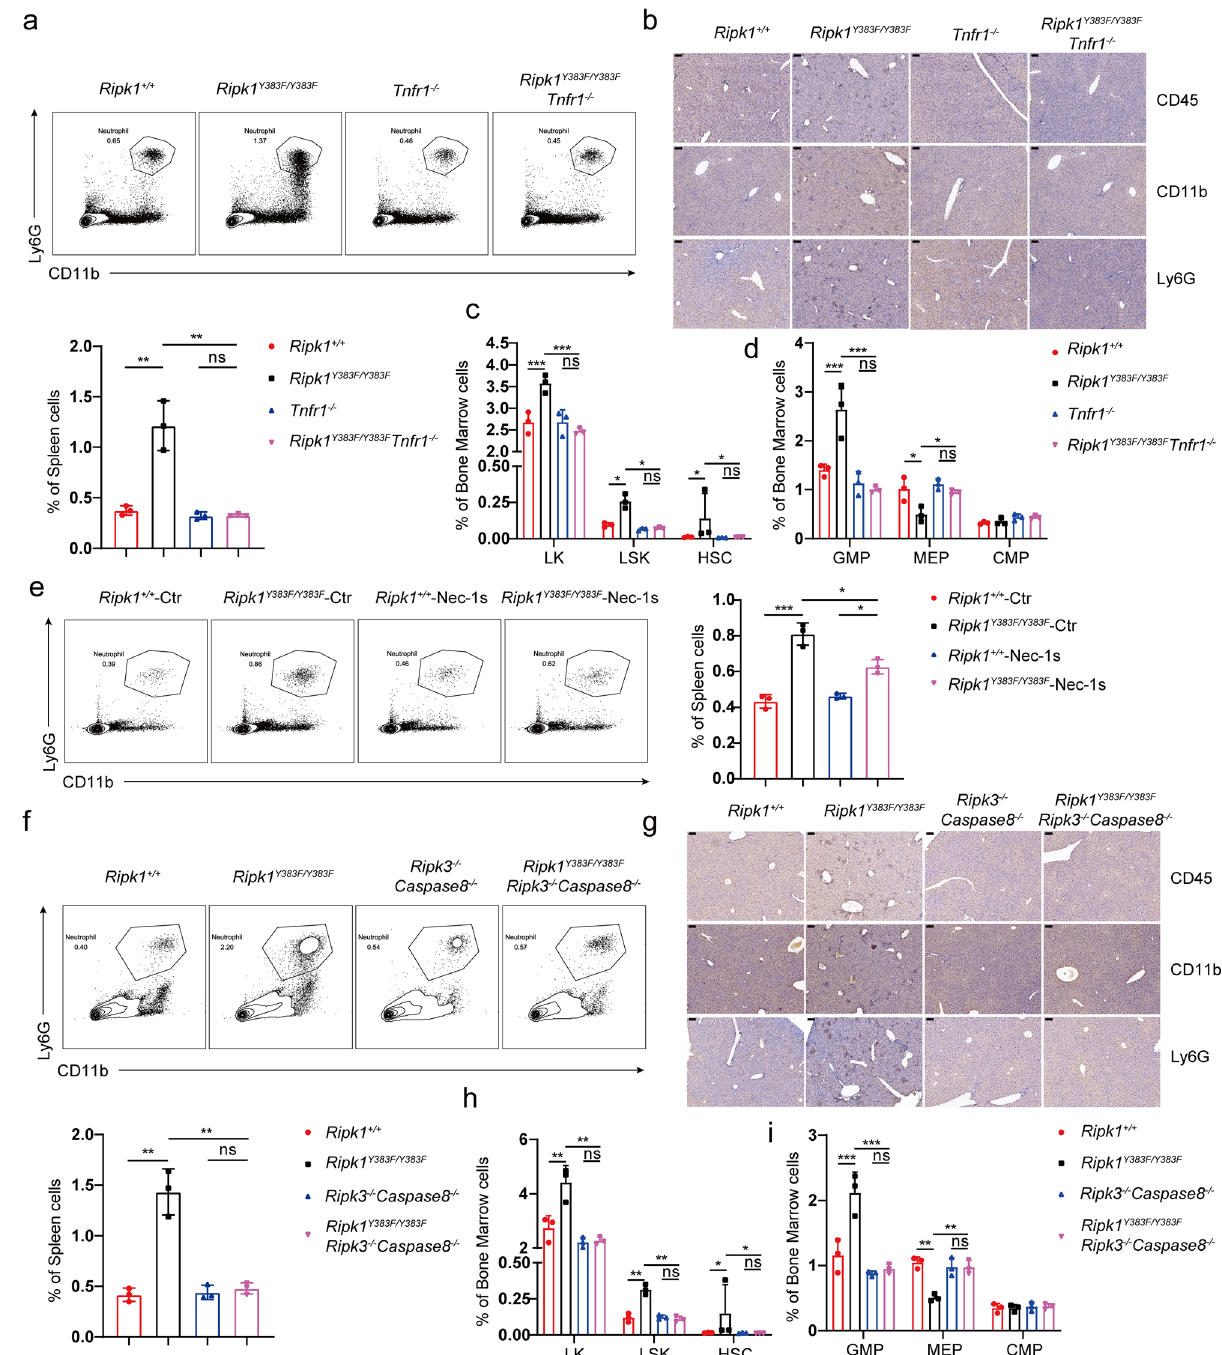
Fig. 6 | TNF-induced cell death is responsible for systemic in fl ammation and emergency hematopoiesis in RIPK1 Y383F mice. a Flow cytometry and statis- tical analysis for neutrophils (CD11b + Ly6G + ) in the spleen from Ripk1 +/+ , Rip- k1 Y383F/Y383F , Tnfr1 − / − and Ripk1 Y383F/Y383F Tnfr1 − / − mice at age of 8 weeks ( n = 3). b Immunohistochemical staining of CD11b, Ly6G, and CD45 of liver sections from Ripk1 +/+ , Ripk1 Y383F/Y383F , Tnfr1 − / − and Ripk1 Y383F/Y383F Tnfr1 − / − mice at age of 8 weeks (Scale bar, 100 μ m). Flow cytometry and statistical analysis in bone marrow for the indicated hematopoietic populations: LKs, LSKs, HSCs ( c ) and GMPs, MEPs, CMPs ( d ) from Ripk1 +/+ , Ripk1 Y383F/Y383F , Tnfr1 − / − and Ripk1 Y383F/Y383F Tnfr1 − / − mice at age of 8 weeks ( n = 3). e Ripk1 +/+ and Ripk1 Y383F/Y383F mice were treated with Nec-1s (3mg/kg) every one day after 3 weeks old ( n = 3). After 8 weeks, neutrophils (CD11b + Ly6G + ) in the spleen from the mice were analyzed